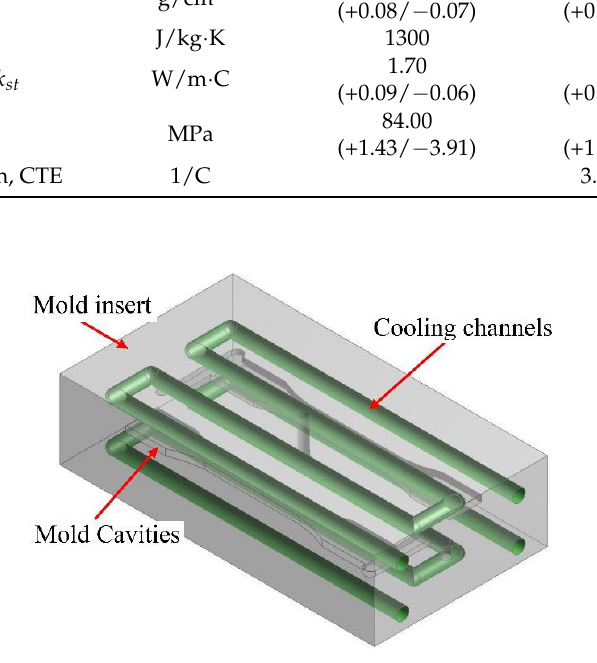
Figure 11. Cavity insert design. Table 5. Transient thermal analysis parameter settings.